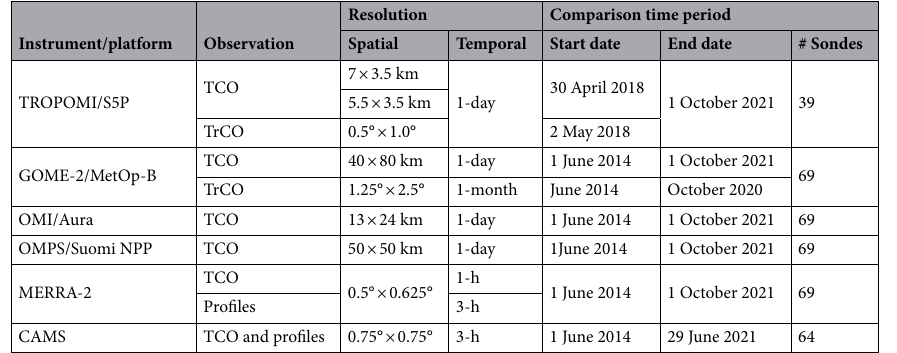
Table 1. Spatial and temporal resolution of satellite and reanalysis products (see “Methods” section) along with number of ozonesondes launched from EMA USFQ in Quito, Ecuador for comparisons.